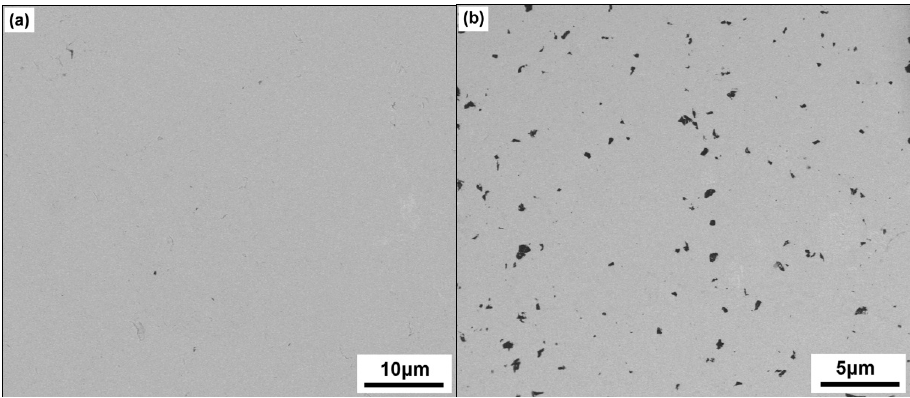
Figure 4. ( a ) SEM microstructure of the sintered pure Cu 2 SnSe 3 ; ( b ) SEM microstructure of sintered 1.6 vol % C 60 /Cu 2 SnSe 3 composite.